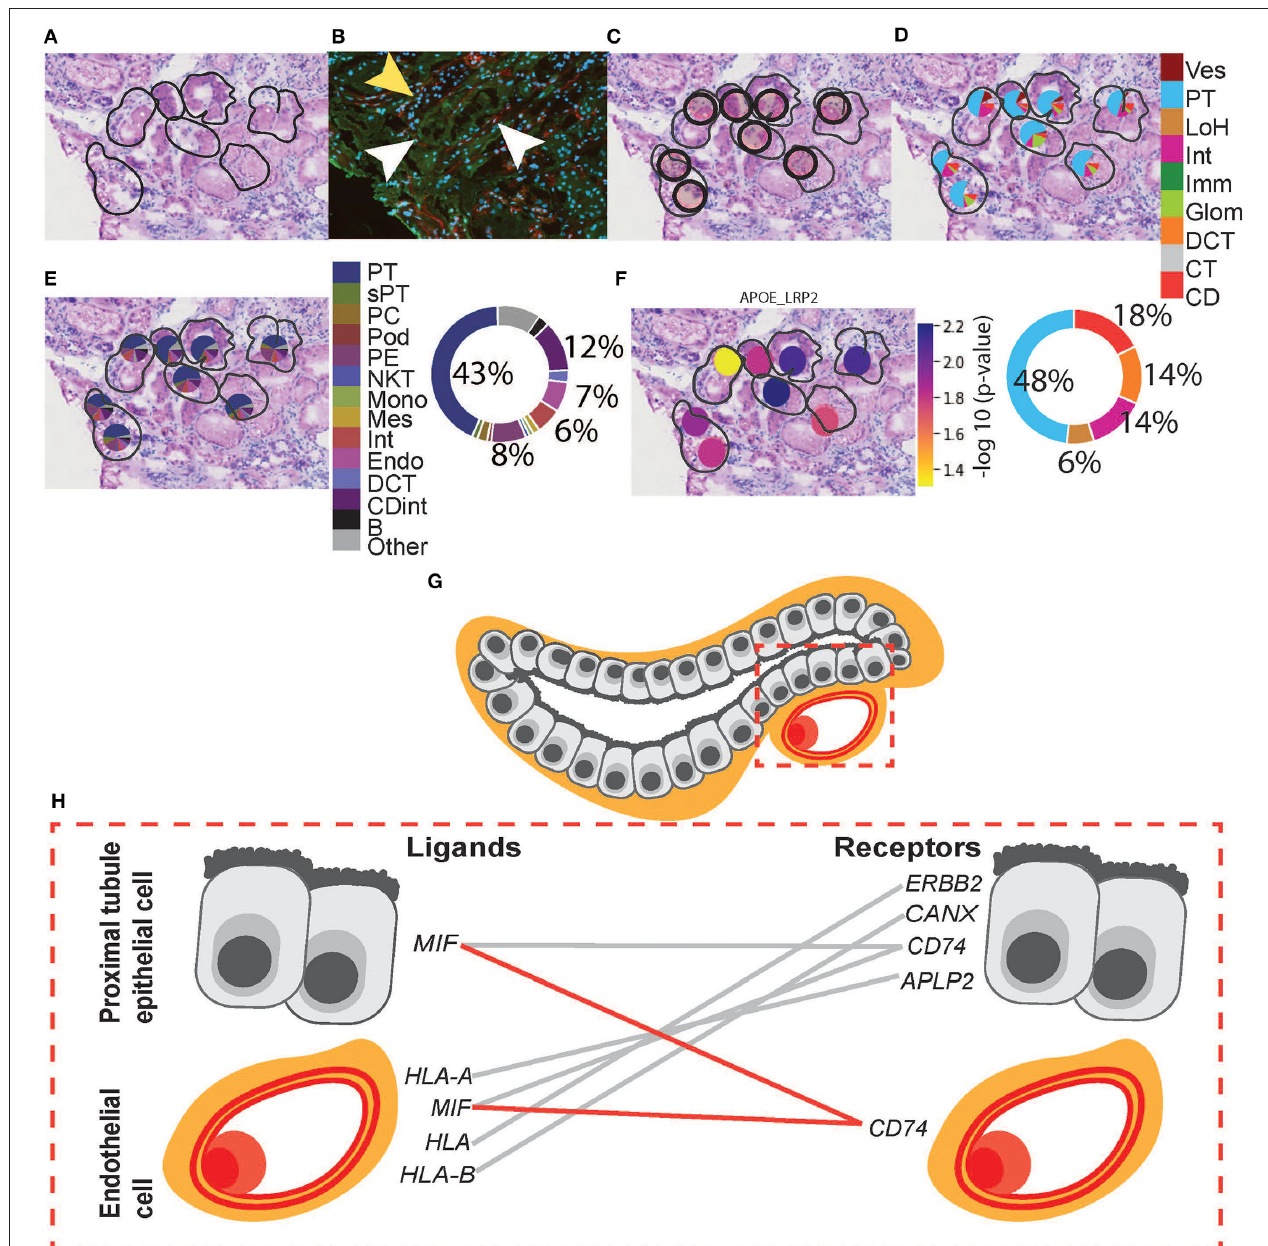
FIGURE 6 | Integrative analysis of PT–PC morphology, deconvolution, and cellular interactions in patient D. To confirm the morphology of PT, we investigated H&E and mIF images within an ROI. (A) Zoomed-in H&E image of PT was annotated by the pathologist. (B) mIF staining with anti-AQP1 (green) demonstrates proximal tubules, anti-CD31 (red; white arrowheads) demonstrates peritubular capillaries, and DAPI (blue) demonstrates nuclei. The mIF staining confirms the presence of PT and PC structures and validates the pathologist’s annotation. (Note: yellow arrowhead denotes tubular patterned DAPI staining with an absence of anti-AQP1 indicating the presence of non-PT structures). (C) The positions of eight underlying ST-spots were mapped within the selected ROI. To perform deconvolution, we selected the ST-spots identified by label transfer as PT. (D) Deconvolution at the functional structure level for the selected eight PT ST-spots was mapped to the H&E image. The pie chart provides a summary of functional structures underlying all PT ST-spots in the entire tissue section for patient D. (E) Deconvolution at the cell-type level for the selected eight PT ST-spots was mapped to the H&E image. The pie chart provides a summary of the cell types underlying all PT ST-spots in the entire tissue section for patient D. Finally, we investigated our ST-seq datasets for cellular interactions in PT–PC ST-spots. (F) The spatial expression of the APOE-LRP2 L–R gene pair for the selected PT was mapped to the H&E image. (G) A diagrammatic presentation of PT epithelial cells and PC endothelial cells within mammalian cortical kidney regions. (H) The cellular interactions involved in immune modulation within PT–PC cells were mapped. Functional structure level key: Ves—vessels, PT—proximal tubules, LoH—loop of Henle, Int—interstitium, Imm—immune cells, Glom—glomeruli, DCT—distal convoluted tubule, CT—connecting tubule, and CD—collecting duct. Cell-type level key: PT—proximal tubule cell, sPT—proximal straight tubule cell, PC—principal cell, Pod—podocytes, PE—parietal epithelial cell, NKT—natural killer T-cell, Mono—monocytes, Mes—mesangial cell, Int—interstitium, Endo—endothelial cell, DCT —distal convoluted tubule cell, CDint -